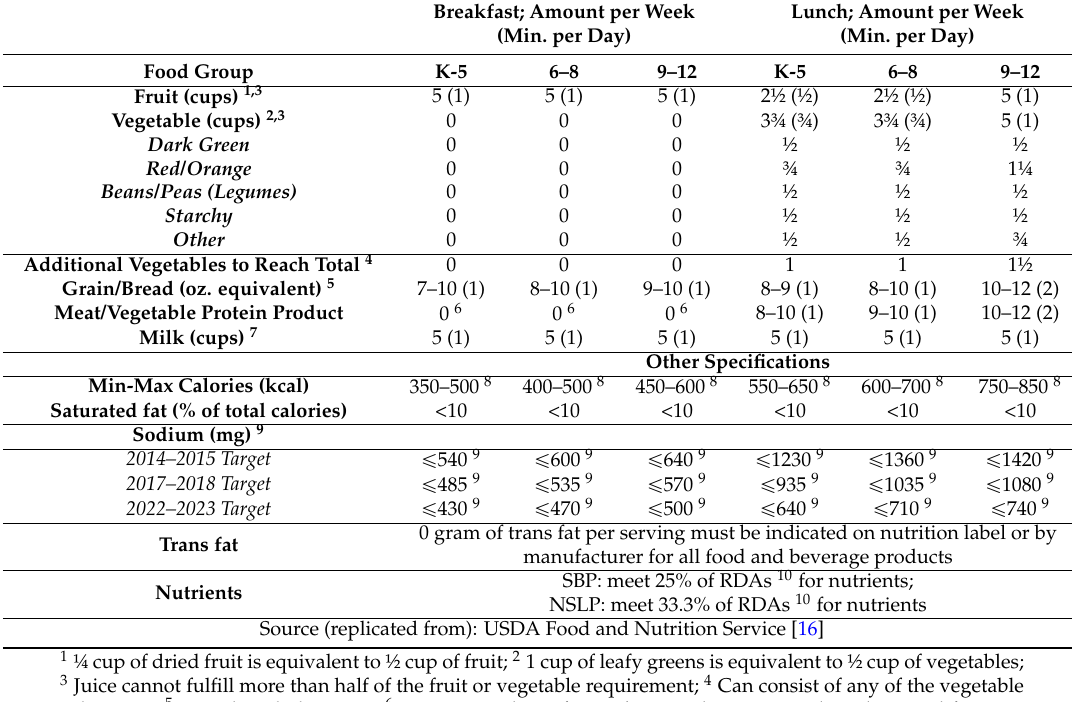
Table 5. Current School Breakfast Program (SBP) and National School Lunch Program (NSLP) Weekly Nutrition